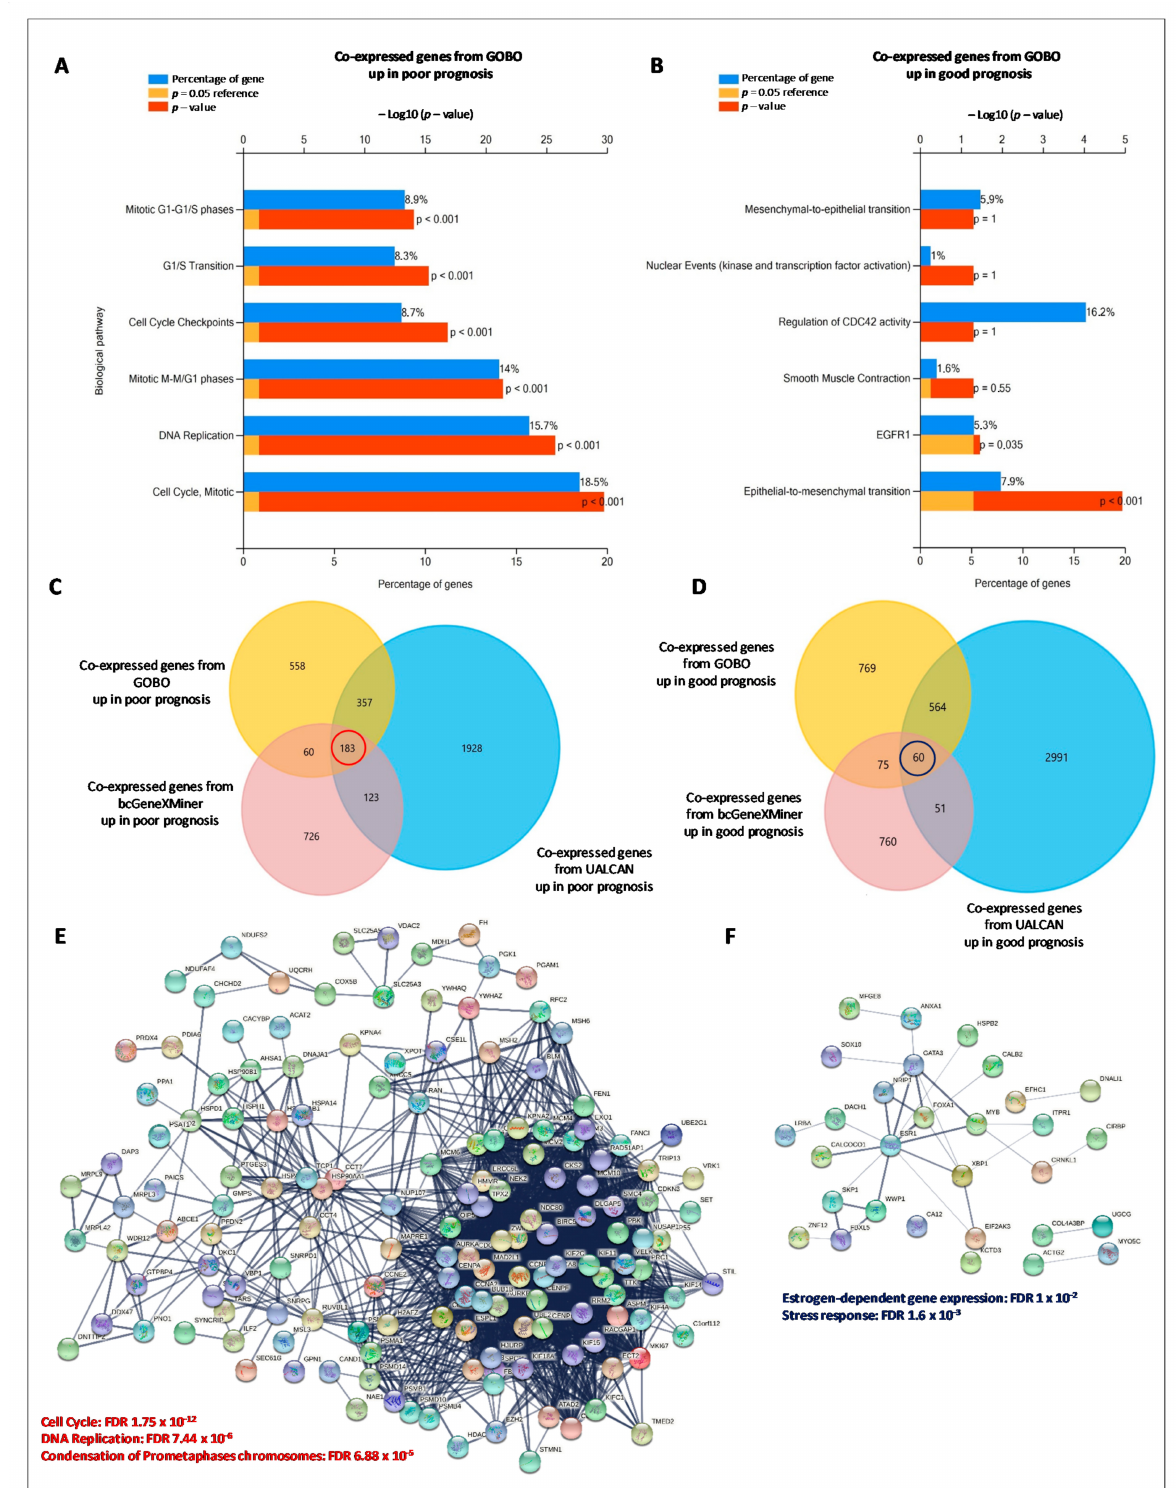
Figure 5. Enrichment pathway analysis of HSPs co-expressed genes significantly correlated with prognosis. Significantly enriched biological pathways were ranked by p -value using the FunRich 3.0 software. ( A , B ) The top six biological